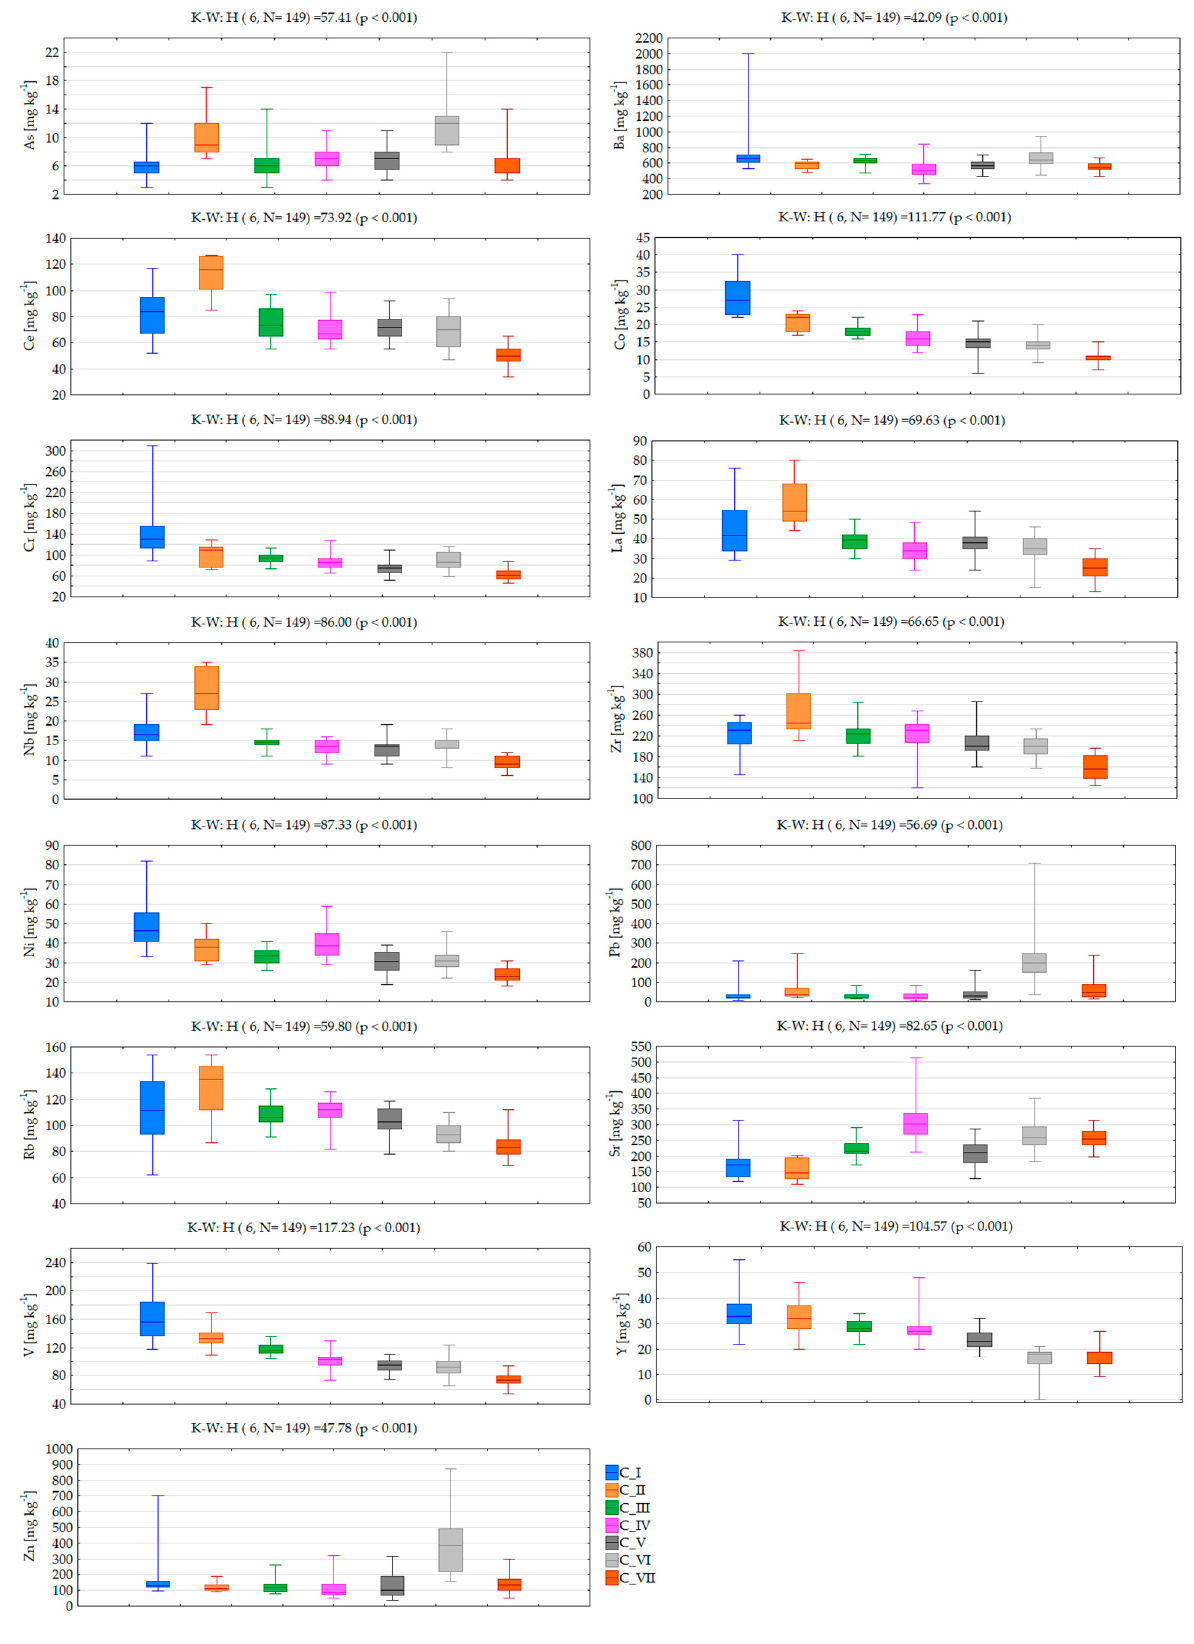
Figure 7. PHE concentration values according to clustering patterns (central line: median, box: 25–75% percentile, whiskers: minimum-maximum) with statistical assessment of differences between clusters based on the Kruskall-Wallis non-parametric test (K-W).